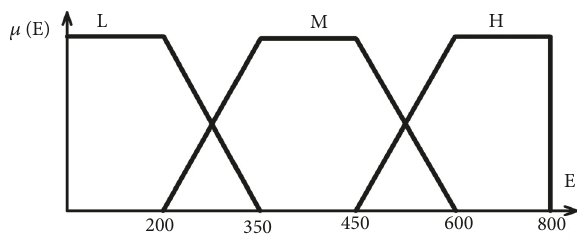
Figure 3: Membership functions for the effective capacity. Defini- tion of the membership functions: L: low; M: medium; H: High.